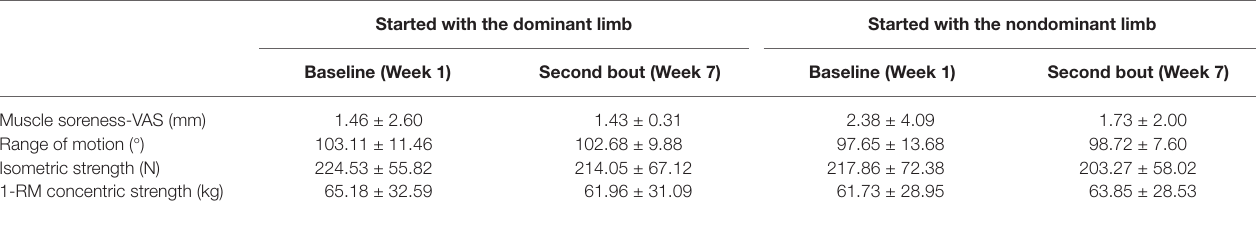
TABLE 1 | Pre-testing values of the muscle damage indirect markers before both baseline and second knee flexion ECC bouts. Started with the dominant